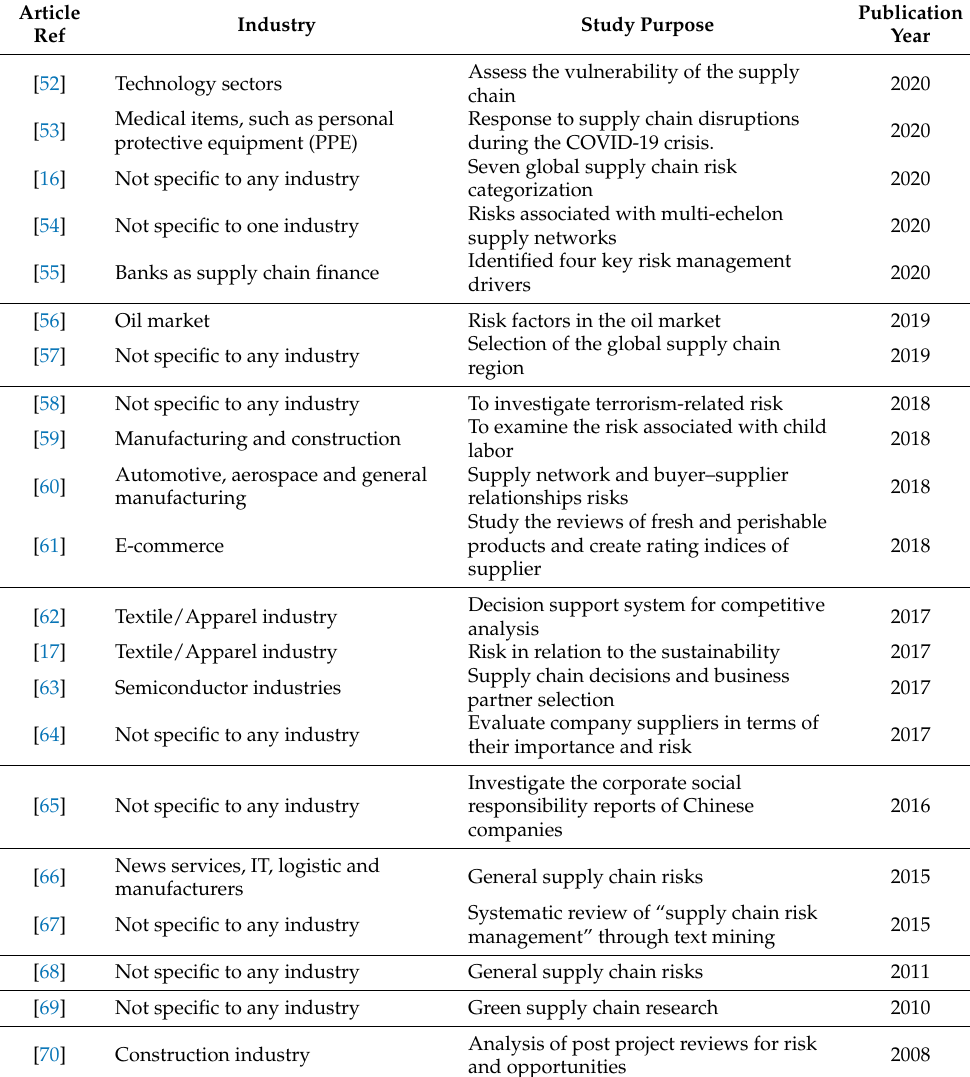
Table 2. Shortlisted research papers as a result of a screening process related to Text Mining and Supply Chain Risk Management as shown in Figure 4.